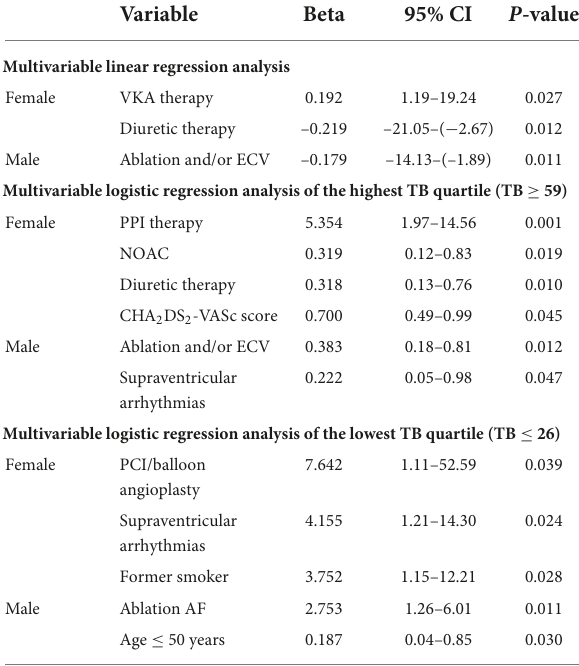
TABLE 3 Multivariable linear regression and logistic regression analyses of treatment burden in atrial fibrillation (AF) patients.